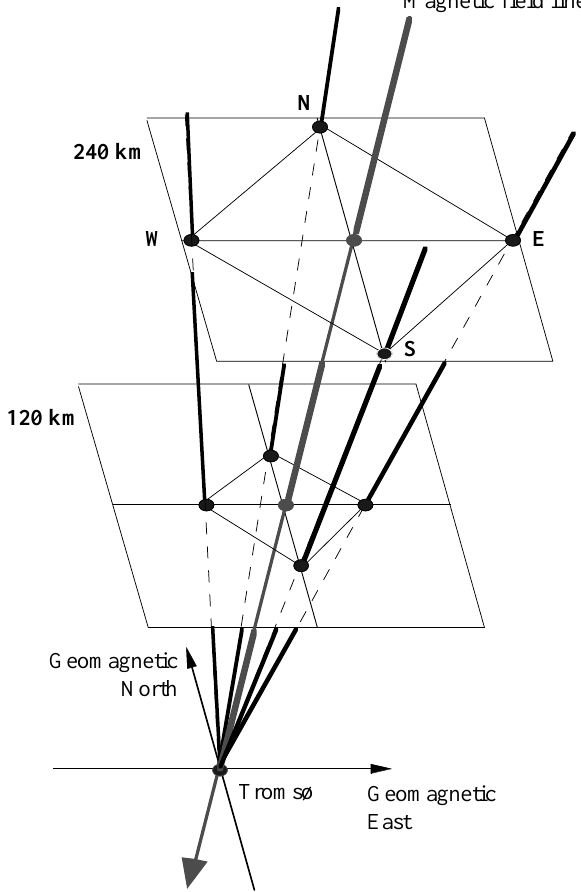
Fig. 1. An illustration of the idealized EISCAT radar mode. The transmitting antenna is sequentially pointed to four positions. Ide- ally, two pairs of the four directions would form the two orthogonal diagonals of a square. In each of the four positions, the electric field in the F-region (240km) is measured with three antennas, and the Pedersen and Hall conductivities are determined along the Tromsø